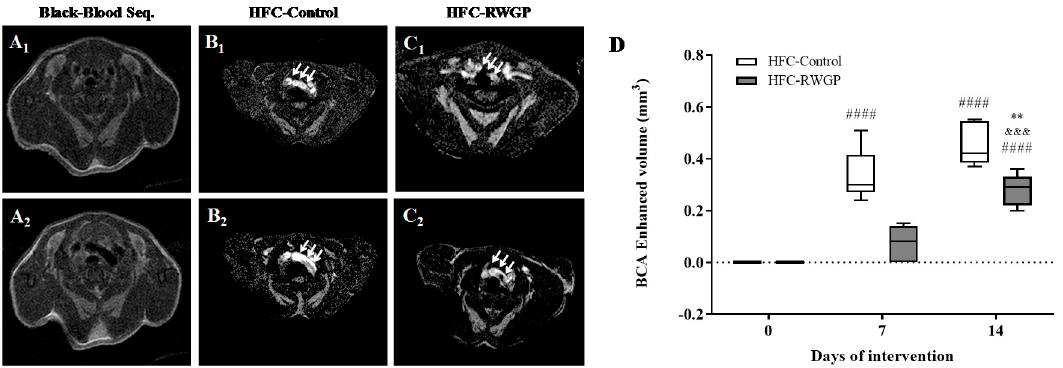
Figure 6. Effect of RWGP supplementation on vessel wall uptake of gadofosveset in SR-B1 KO/ApoER61 h/h mice fed with atherogenic diet. Representative black-blood axial magnetic resonance imaging (MRI) of the supra-aortic vessels ( A1 ) and the aortic arch ( A2 ). Inversion recovery MR images showing gadofosveset accumulation in vessel walls of mice fed HFC-Control ( B1 , B2 ) or HFC-RWGP ( C1 , C2 ) diets for 14 days. White arrows show areas of contrast uptake in aortic arch and supra-aortic vessels. ( D ) Quantification of contrast uptake in vessel walls at 14 days of dietary manipulations. Data are shown in box plots (box, 25th to 75th percentiles; whiskers, median and IQR) ( n = 5–7). #### p < 0.0001 compared to day 0; &&& p < 0.001 compared to day 7; ** p < 0.01 vs. HFC-Control based on two-way